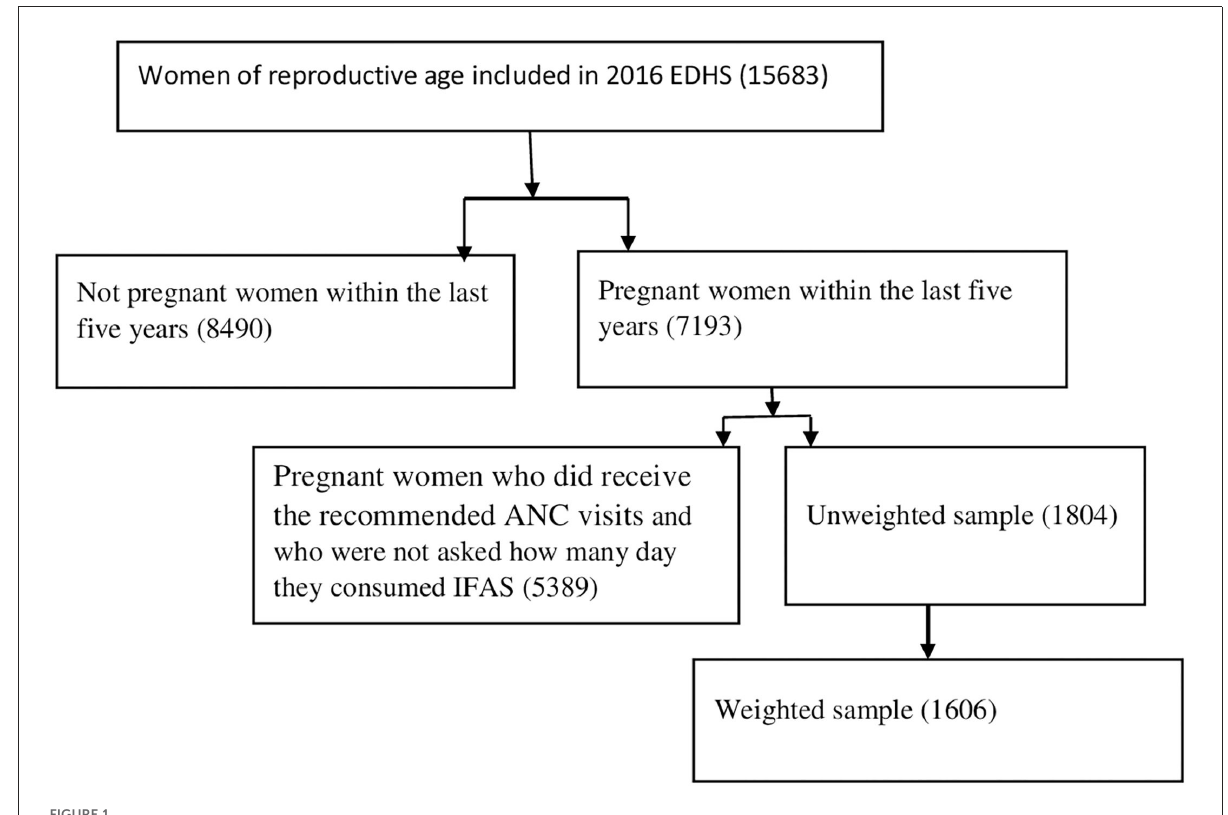
FIGURE1 Data extraction procedures and sample